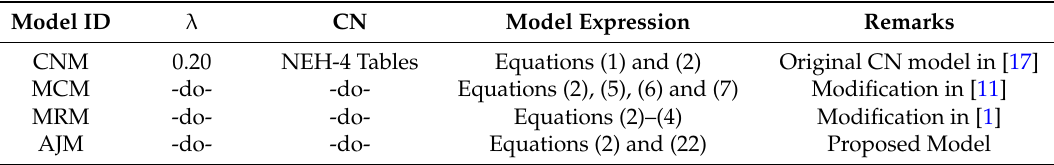
Table 3. Models and their corresponding parameters